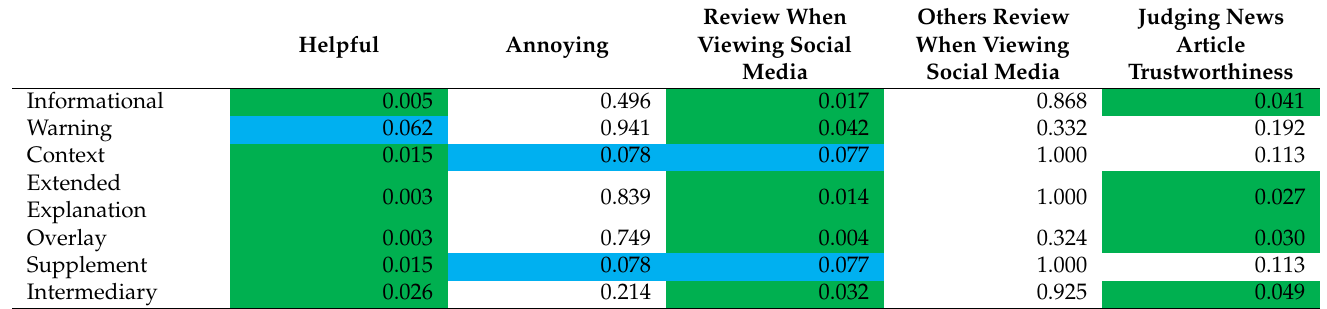
Table A5. Statistical significance calculations for university comparison data.